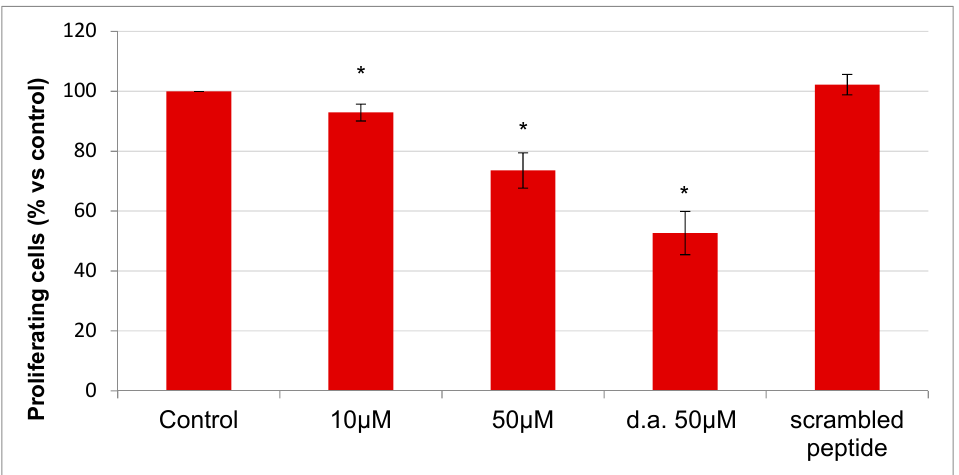
Figure 7. Proliferation assay. HepG2 were treated with the peptide at different concentrations. Cell proliferation was evaluated considering the normalized cell index (CI) of each curve at about 24 h after treatment; results are presented as the percentage of CI of adherent cells versus control (cells not treated). HepG2 were also treated with 50 µM RGDechi15D with a second addition of 50 µM peptide (d.a. = peptide double addition) after 6 h. The results are expressed as means ± SE of at least three independent experiments performed in triplicate. Statistical significance was analyzed using Student’s t test, unpaired, two-sided (* p < 0.05).